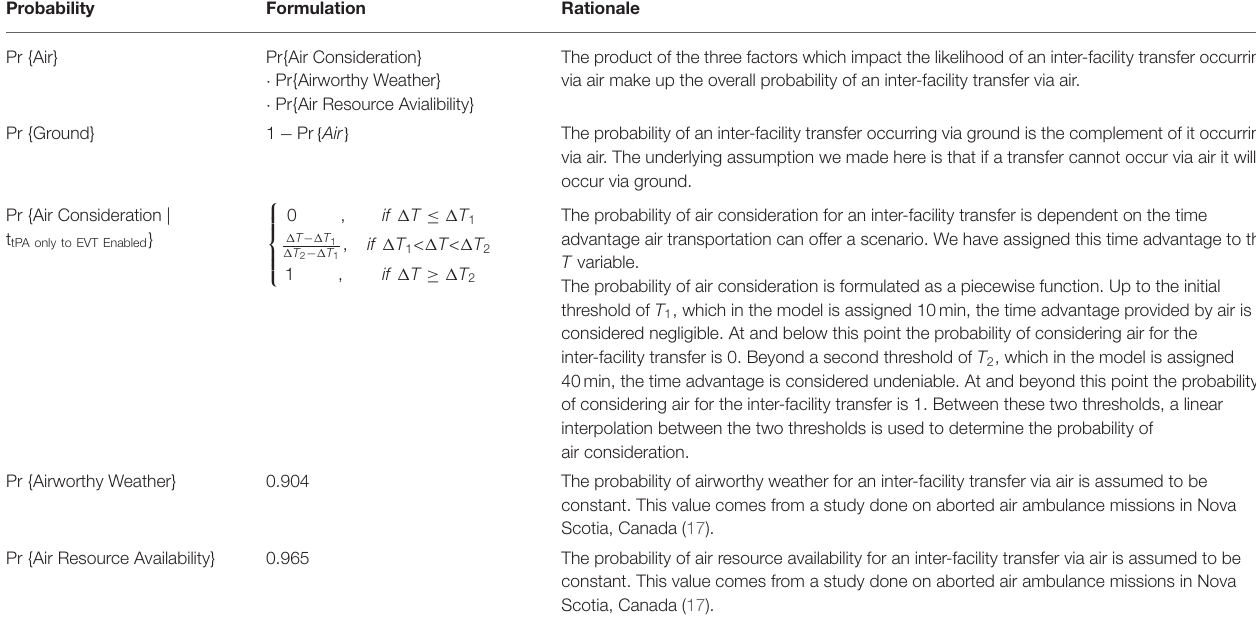
TABLE 1 | Formulation for probability of using air transport in the Drip-and-Ship Strategy.